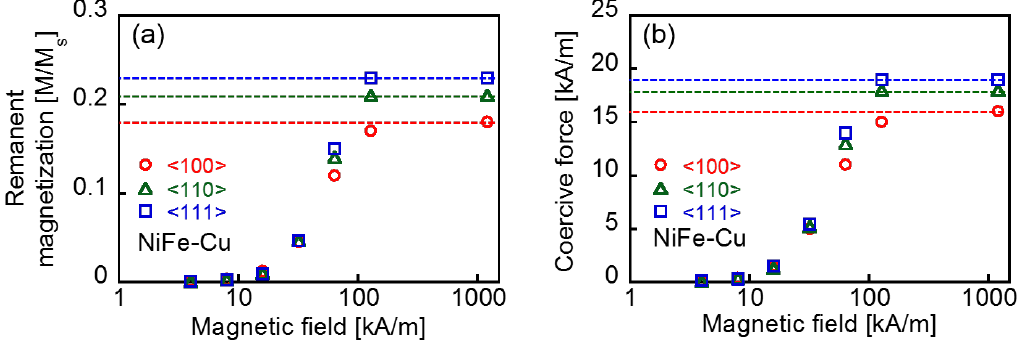
Figure 5. Remanent magnetization ( a ) and coercive force ( b ) of the DC minor loops obtained under different applied magnetic field intensities, H DC , of the NiFe-Cu nanocubes. The dotted lines indicate each value obtained from the DC major loops ( H DC = 1200 kA/m) shown in Figure 3.